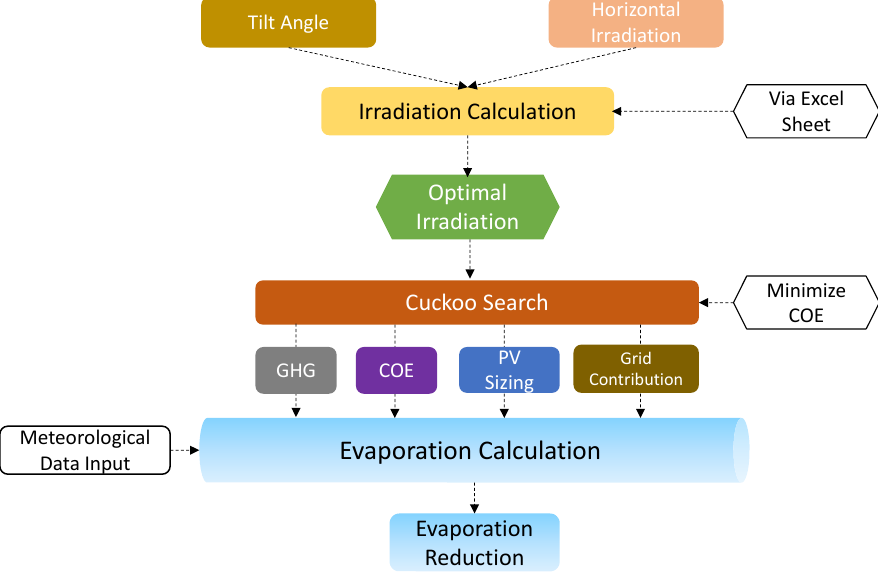
Figure 3. Canal-top PV accommodation sizing and impacts.